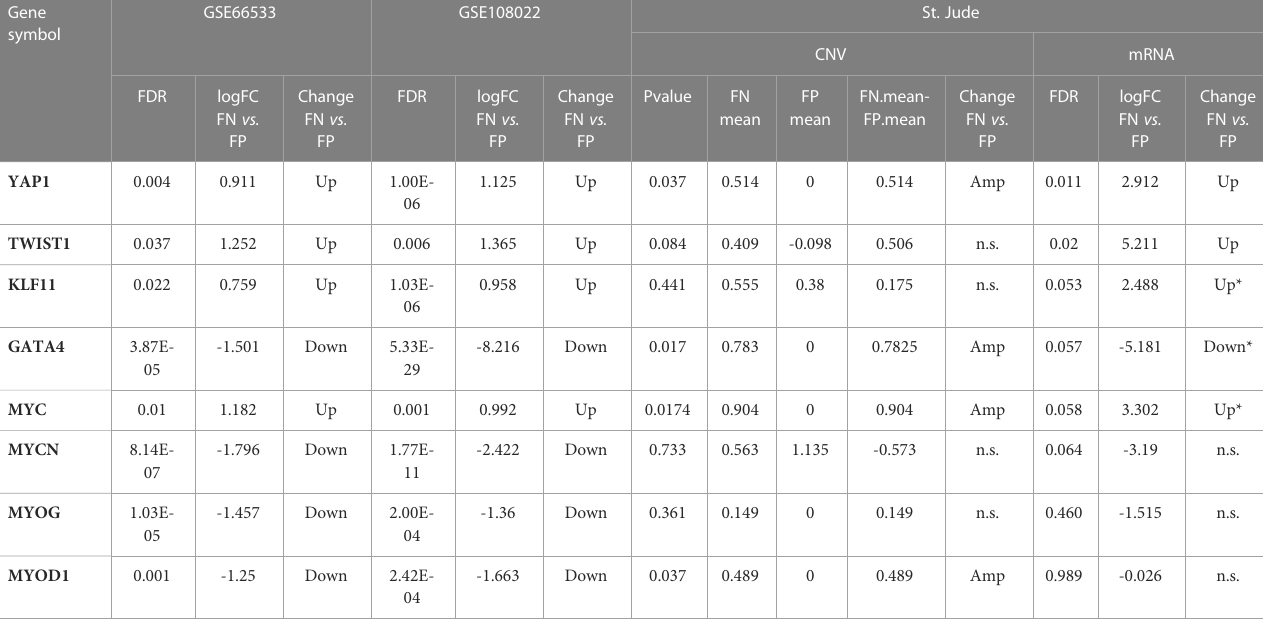
TABLE 4 The differential expression and copy number change for the enriched upstream regulators for the identi fi ed